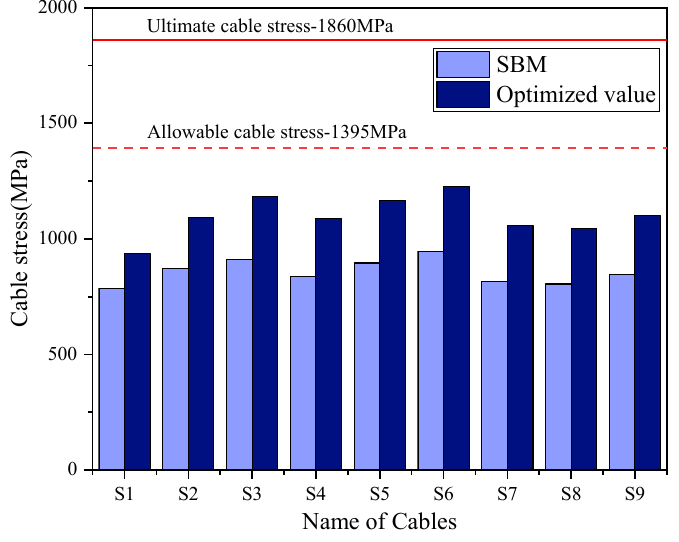
Figure 18. Stress values of cable before and after optimization.